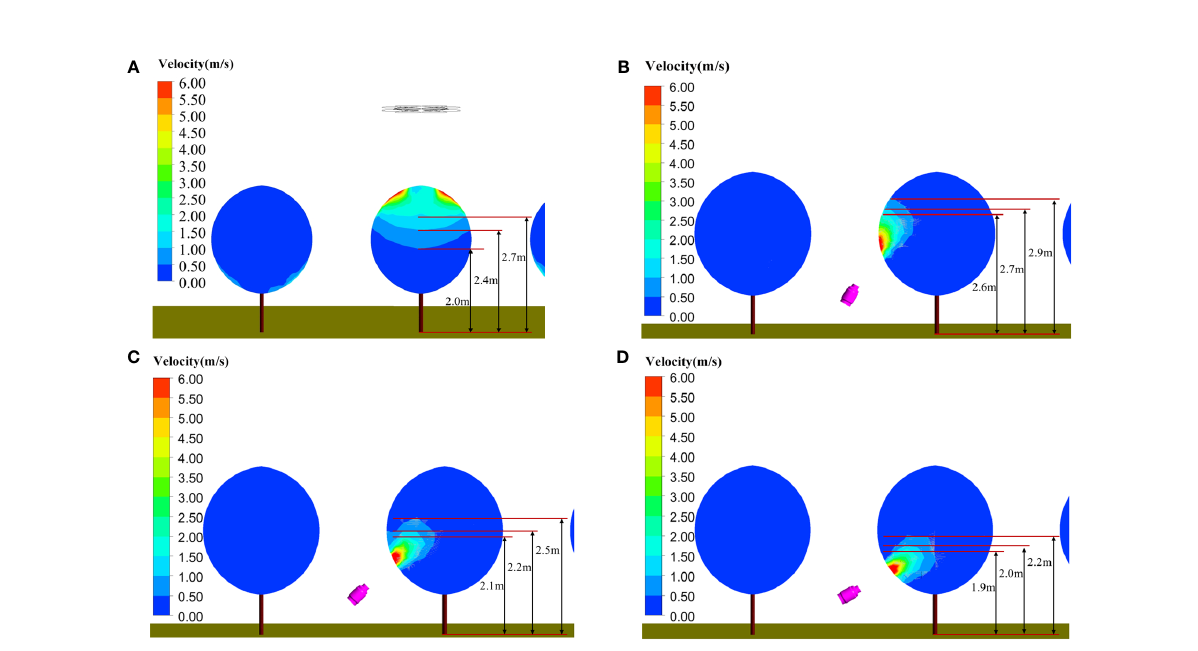
FIGURE 13 Comparison of canopy wind fi eld coupling under different operating parameters. (A) Plant-protection UAV operation height 2.0 m. (B) Swing- arm angle of swing-arm sprayer 60°. (C) Swing-arm angle of swing-arm sprayer 45°. (D) Swing-arm angle of swing-arm sprayer 30°.